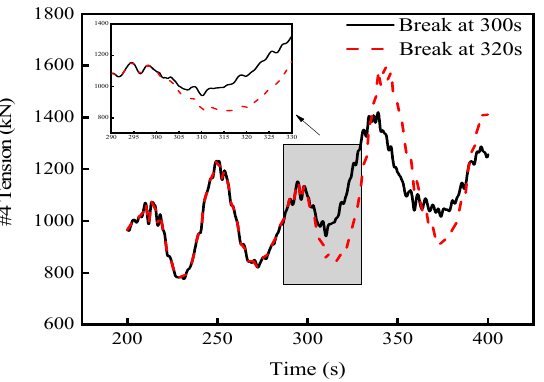
Figure 21. Comparison of #4 tension when #3 breaks at different